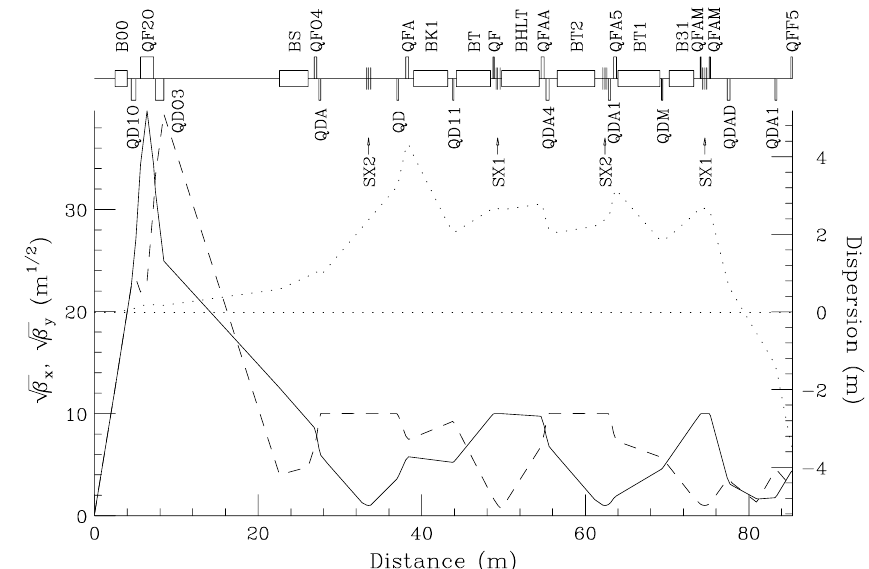
FIG. 48. Example (b): Lattice structure of the IR including local chromaticity corrections. b x (solid line), b y (dashed line), and dispersion (dotted line). The maximum and minimum b x are 1571.74 and 0.040 m, the maximum and minimum b y are 1550.94 and 0.040 m, while the maximum and minimum dispersions are 4.31 and 2 3.50 m. The natural horizontal and vertical chromaticities are 2 41.46 and 2 39.90 , giving a transition gamma of g t (cid:1) 5.52 . The total module length is 85.32 m with a total bend angle of 1.307 rad.